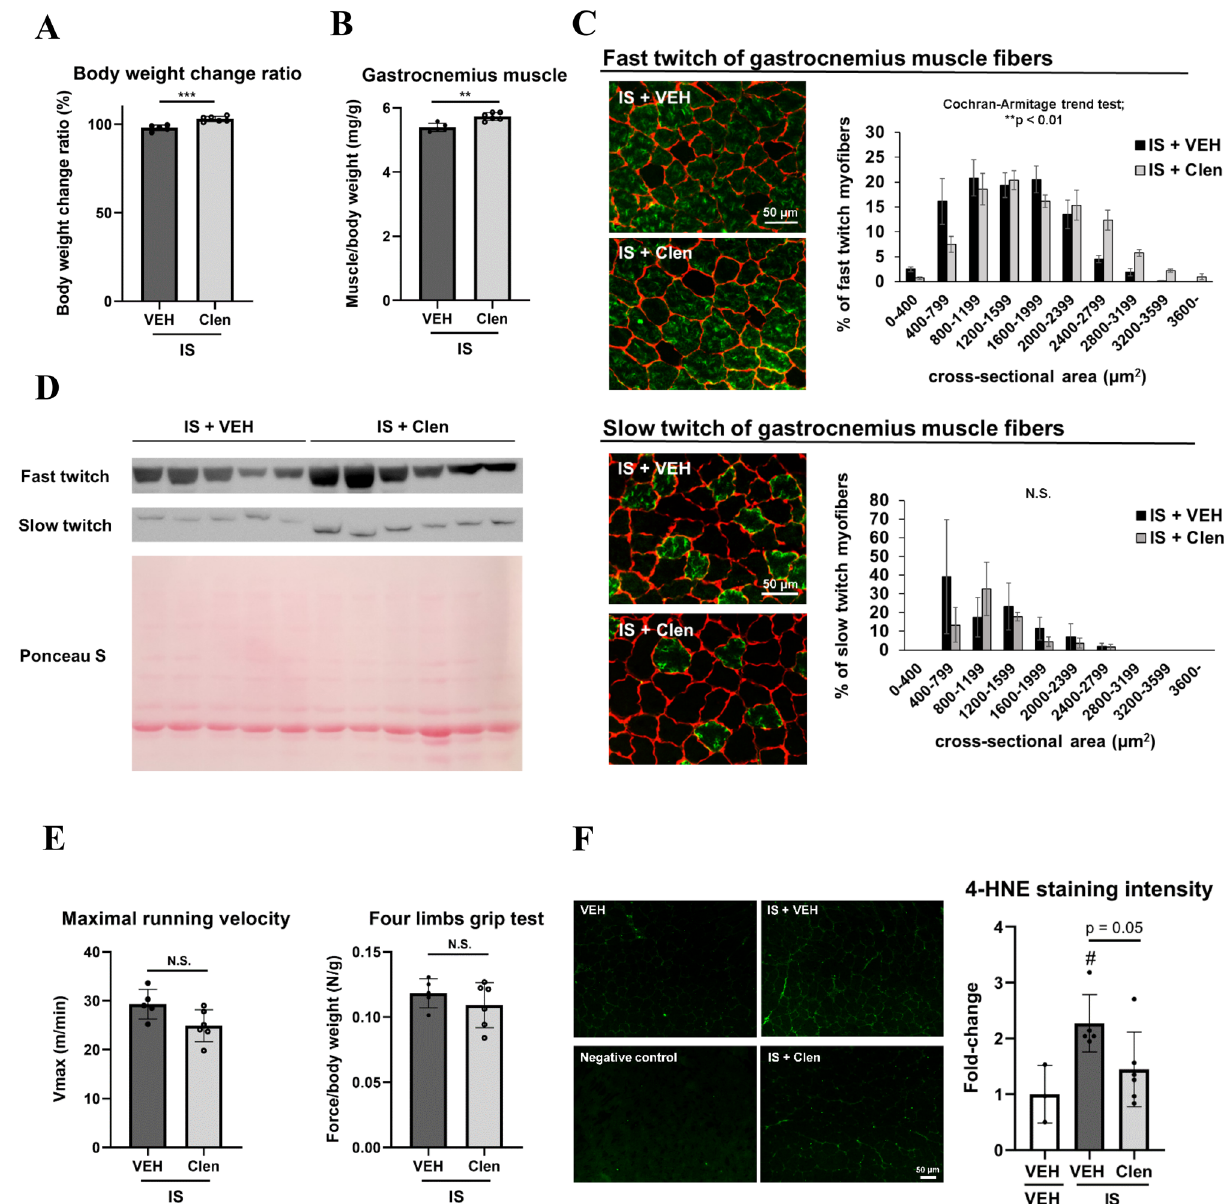
Figure 4. β2-AR agonist, clenbuterol treatment increased GC muscle mass and protein expression of MHC even with IS treatment, but could not reverse muscle weakness. ( A ) The ratio of mouse body weight change before and after one-week treatment of indoxyl sulfate (IS), and IS plus clenbuterol is shown. ( B ) The ratio of gastrocnemius (GC) muscle wet weight over the total body weight of mice after one-week treatment is shown. ( C ) Immunohistochemical analysis of fast (top, green) and slow (bottom, green) myosin heavy chain (MHC) isoforms counterstained with laminin (red) was performed for mouse GC muscle cryosections obtained from those 2 groups. The scale bar is 50 μm. The cross-sectional area and size distribution of fast and slow myofibers was quantitated (right). As a statistical analysis, a Cochran-Armitage trend test for fiber size distribution was performed. N = 5–6 (fast twitch) and 3 (slow twitch) mice per group. Error bars denote SEM. ( D ) Western blotting analysis of the fast and slow MHC isoforms in GC muscle obtained from those 2 groups was performed (top). Ponceau S staining was examined as a loading control (bottom). A full-length view of the membrane is shown in the supplementary Fig. 4. ( E ) Maximal running velocity (Vmax) measured in treadmill running exhaustion tests (left) and grip strength measured in four limbs grip tests (right) are shown. ( F ) 4-HNE staining on mouse GC muscle cryosections after one week of treatment with vehicle or clenbuterol and IS (left). The same cryosections without adding the first anti-4-HNE antibody were also examined as a negative control. The scale bar is 50 μm. Signal intensity was quantitated (right). N = 3–6 mice per group. Error bars indicate SEM. ** p < 0.01, *** p < 0.001. #; p < 0.05 compared to vehicle (VEH) without IS treatment. Clen; clenbuterol. N.S.; no